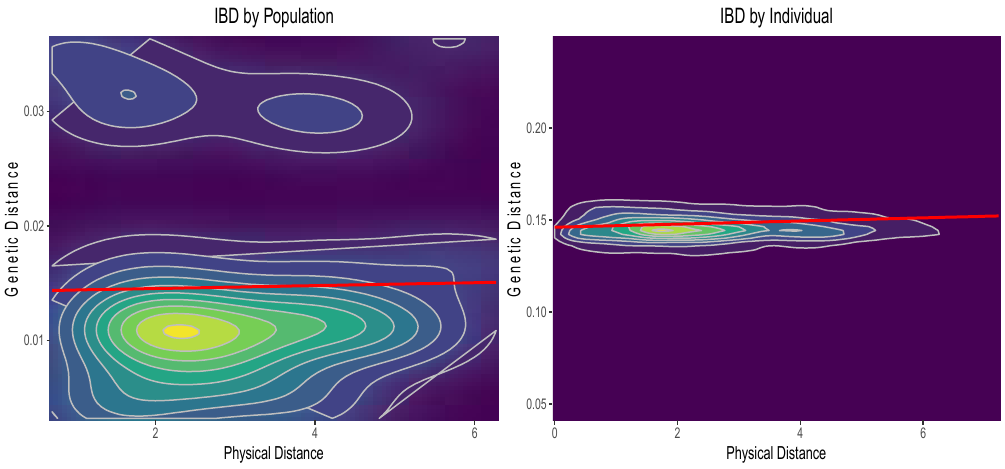
Figure A5. Results of the Mantel tests. IBD refers to Isolation by distance, and “physical distance” refers to geographic distance among populations.